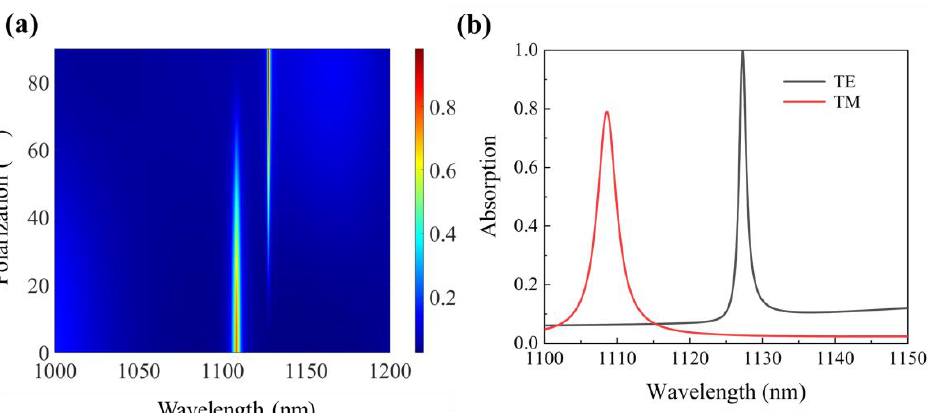
Figure 10. ( a ) Polarization dependent light absorption spectrum of the absorber. ( b ) Absorption of the proposed absorber under the illumination of TE and TM polarized normal incident light.